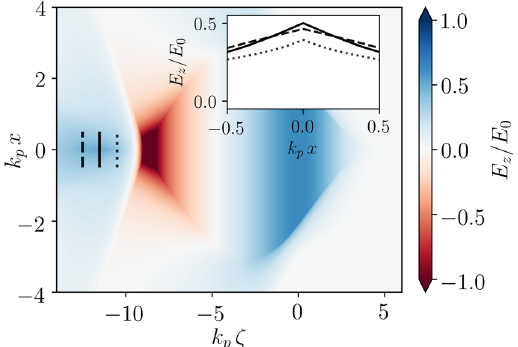
FIG. 1. Two-dimensional ( ζ , x ) map of the accelerating wake- =E 0 . Positrons can be accelerated in the region field, E z − 14 ≲ k ζ ≲ − 10 . Inset: transverse dependence of accelerating p field in the positron accelerating region at three different ζ ¼ − 12 . 5 ), longitudinal locations denoted by the dashed ( k p ζ ¼ − 11 . 5 ), and dotted ( k ζ ¼ − 10 . 5 ) lines. The accel- solid ( k p p erating field falls off for increasing distance from the propagation axis. The gradient of the transverse field decreases further behind the driver.